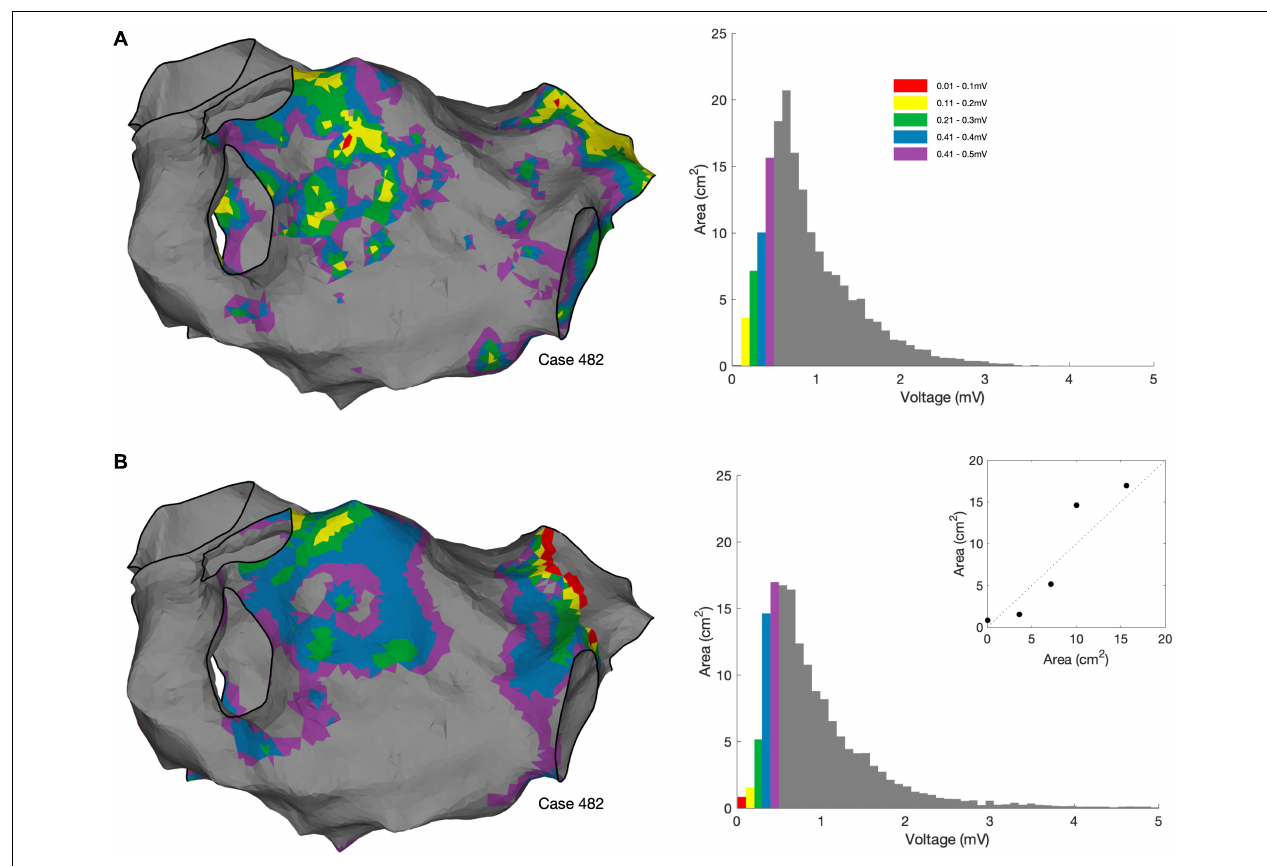
FIGURE 11 | Voltage histogram analysis. (A) Voltage histogram analysis performed using bipolar voltages exported from the clinical mapping system. OpenEP command: voltageHistogramAnalysis(userdata, 'plot', true, 'method', 'map') . (B) Voltage histogram analysis performed using bipolar voltages re-interpolated from the exported electrogram voltage annotations using the OpenEP command voltageHistogramAnalysis (userdata, 'plot', true, 'method', 'egm') . Inset in lower panel shows the comparison in areas between the two